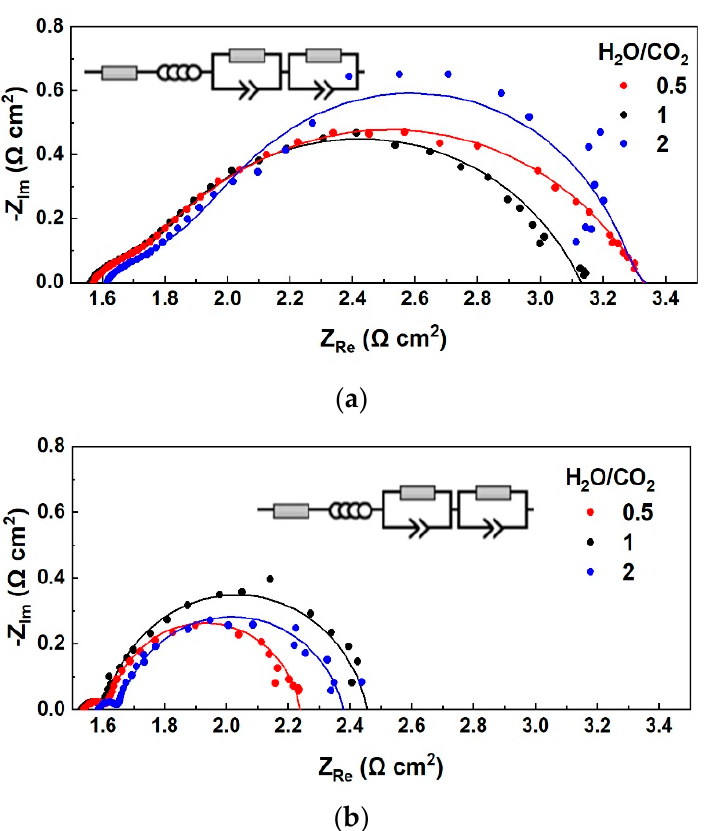
Figure 5. The electrochemical performance of the button cell under co-electrolysis. Nyquist plots recorded at ( a ) 0 mA cm − 2 (open circuit) and ( b ) 250 mA cm − 2 for different H 2 O/CO 2 ratios in the fuel electrode feed in balance with He for a frequency range of 100 kHz–10 mHz and an amplitude of 20 mA.